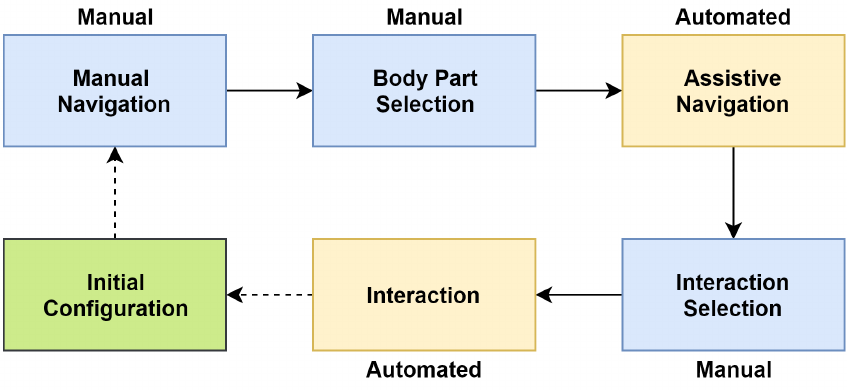
Figure 12. State diagram of assistive navigation (adapted from: